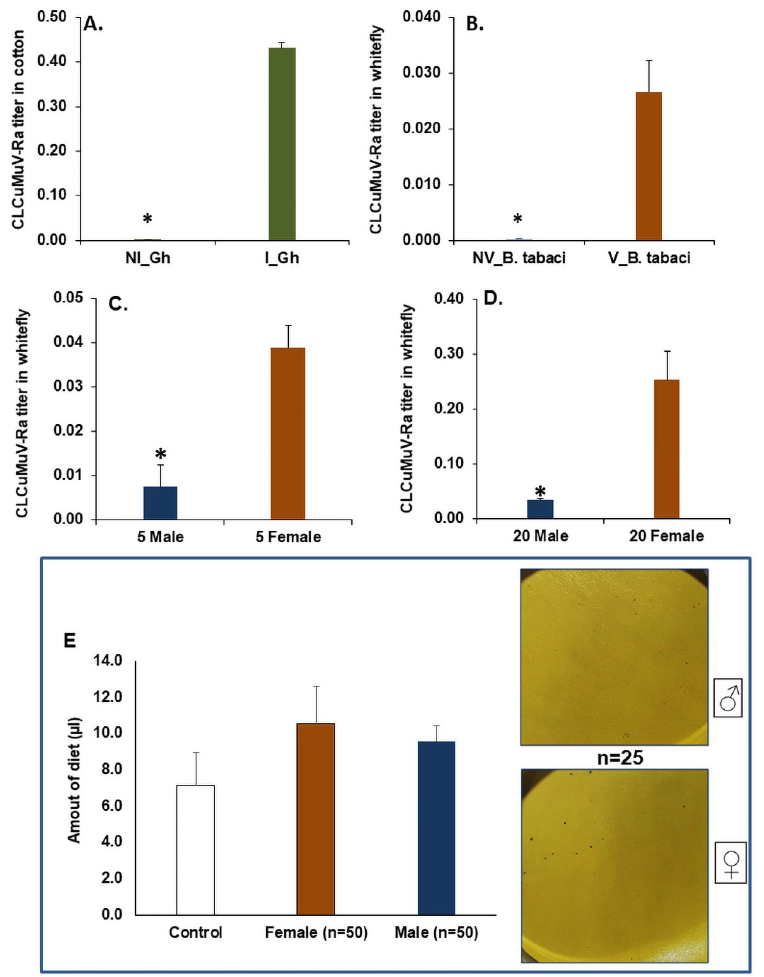
Fig 1. Validating the specificity of Cotton leaf curl Multan virus -Rajasthan primers in A. Non-infected (NI) and Infected Gossypium hirusutum ; B. Non-viruliferous (NV) and Viruliferous (V) Bemisia tabaci ; Relative amount of CLCuMuV-Ra in B . tabaci , C. n = 5 males and 5 females, D. n = 20 males and 20 females; E. Relative amount of sucrose diet fed by male and female whiteflies (n = 50), the control bar represents the diet loss due to evaporation. The fluid loss assay on water sensitive paper represented by number of blue dots shows the qualitative estimation of excretion by male and females (n = 25). The expression level (A-D) was normalized with B . tabaci β -tubulin as housekeeping gene. The error bars represent the standard deviation (n = 3) and � represents significant differences (P � 0.05, Student’s t-test).